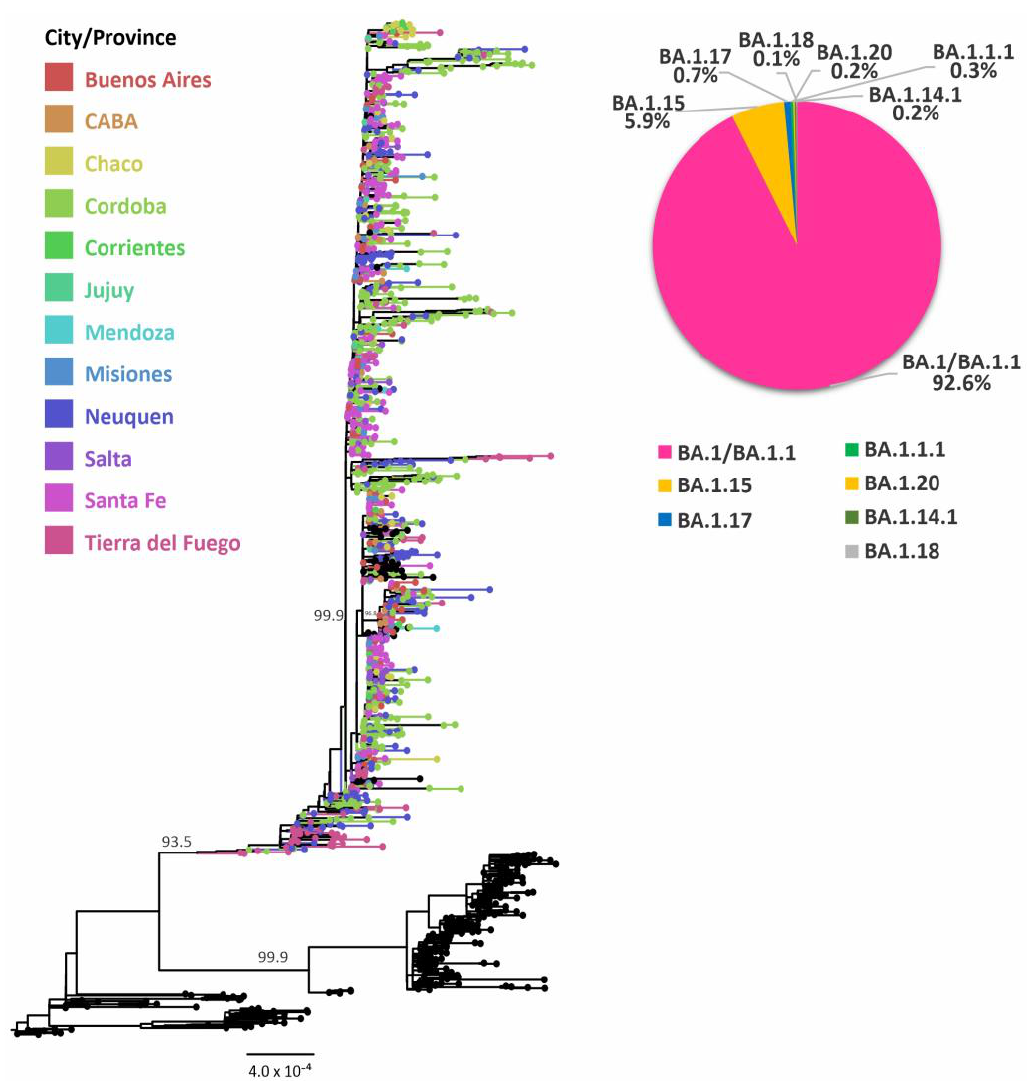
Figure 3. Phylogenetic tree of SARS-CoV-2 sequences focused on Omicron BA.1 and its sublineages. SH-aLRT support values are indicated at nodes for some groups. The branches and tips of the tree are colored according to the City or Provinces indicated in the legend. Black-colored tips represent sequences from other countries or sequences included as references for other lineages. Table 1. Population dynamic parameters estimated from Bayesian coalescent analyses 1 .